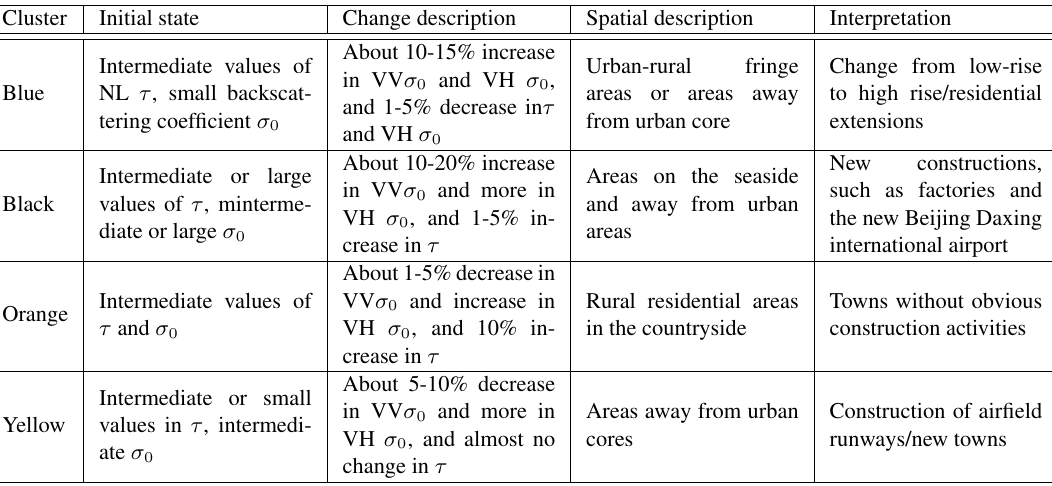
Table 2. Interpretation of change patterns in the Jingjinji